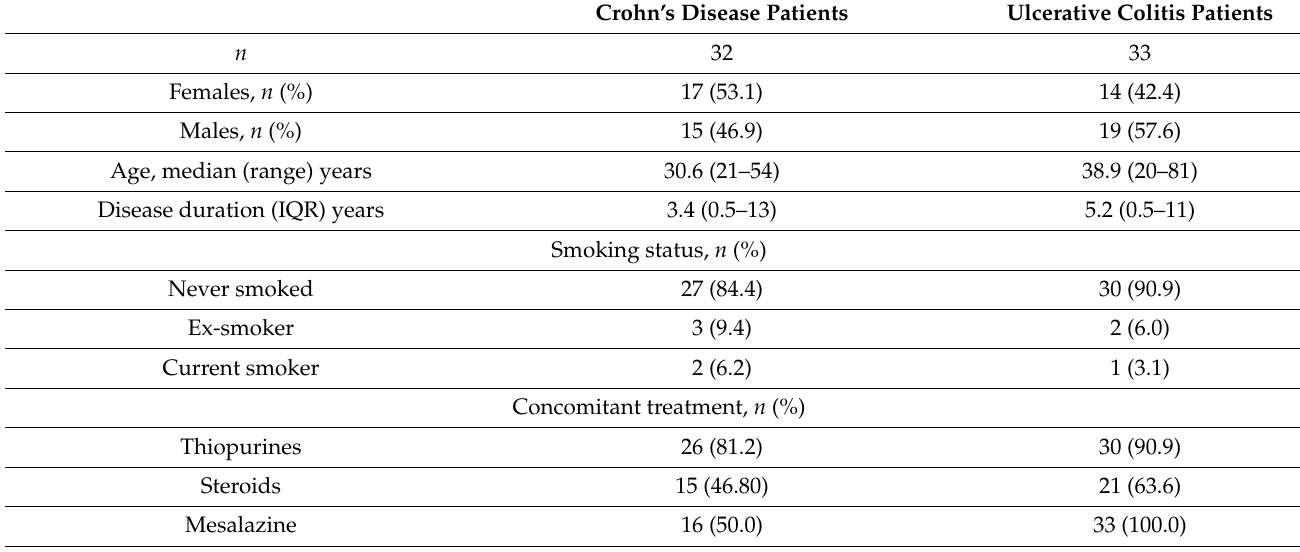
Table 1. Patient baseline